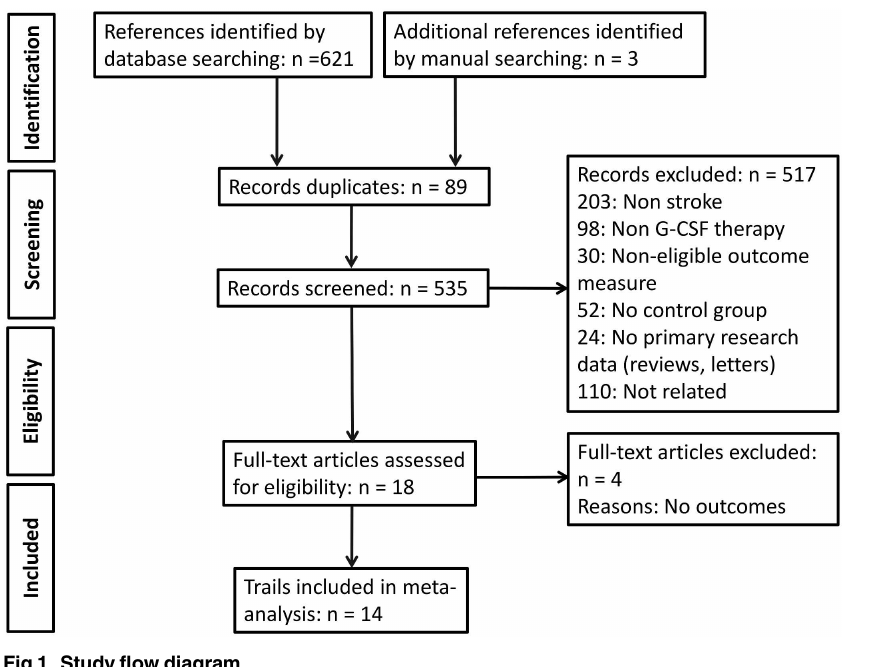
Fig 1. Study flow